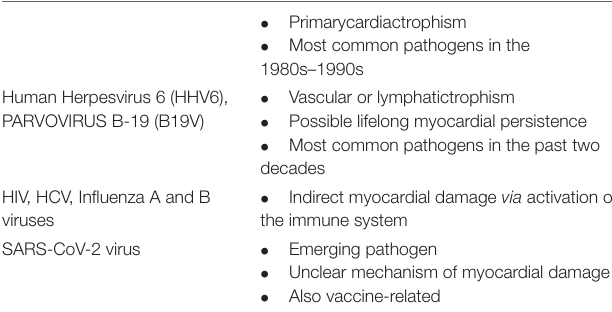
TABLE 1 | List of the most common viruses causing